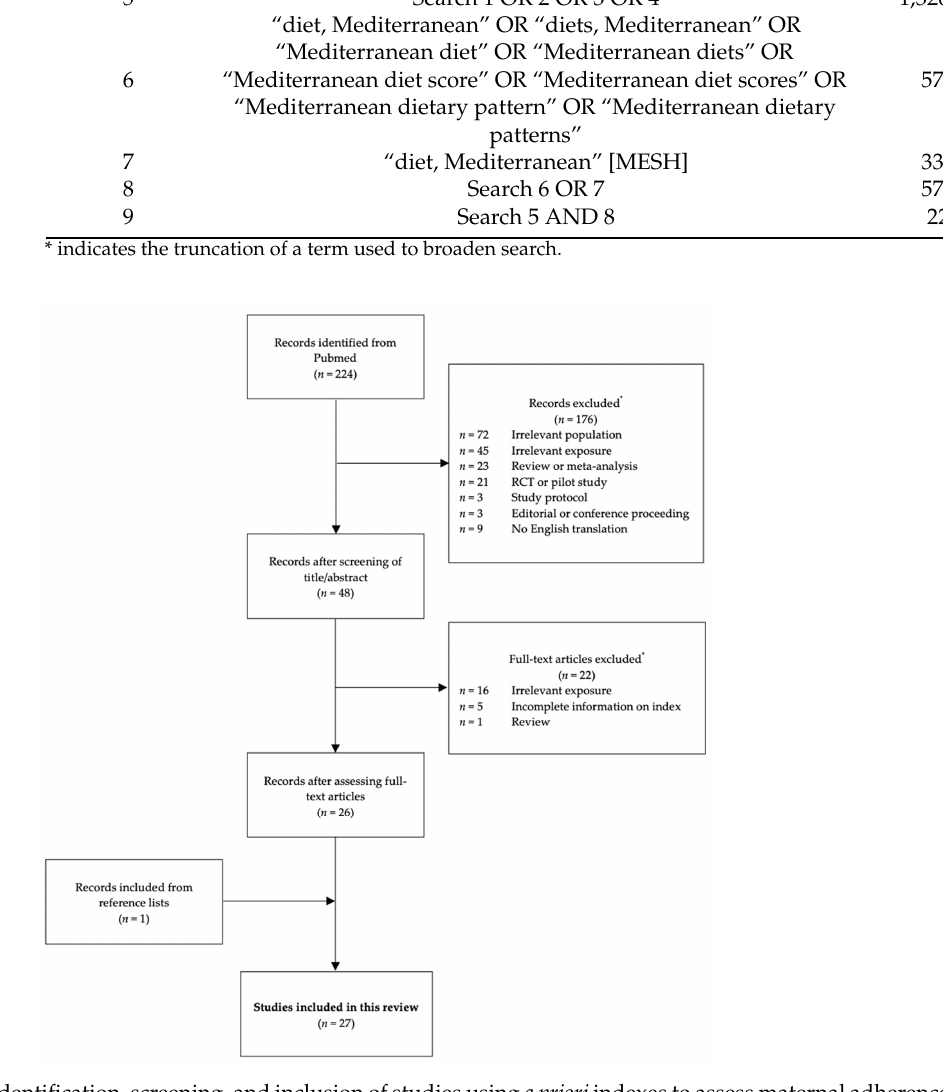
Figure 1. Flowchart of identification, screening, and inclusion of studies using a priori indexes to assess maternal adherence to the MD during pregnancy. * Exclusion criteria for review: (1) Irrelevant population (e.g., non-pregnant, pre-pregnant, or peri-conceptional study population), (2) irrelevant exposure (i.e., exposure not pertaining to adherence to MD), (3) incomplete information on the a priori index in methods, (4) non-observational study design study (e.g., RCT), (5) reviews, meta-analyses, editorials, or conference proceedings, and (6) no English translation available. Abbreviation: MD, Mediterranean diet; RCT, randomized controlled trial.